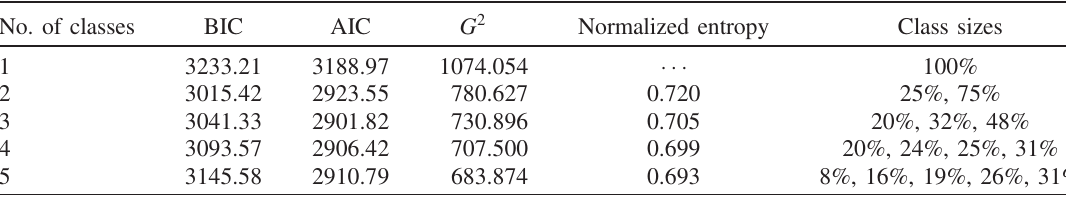
TABLE V. Fit indices for LCA and class sizes.